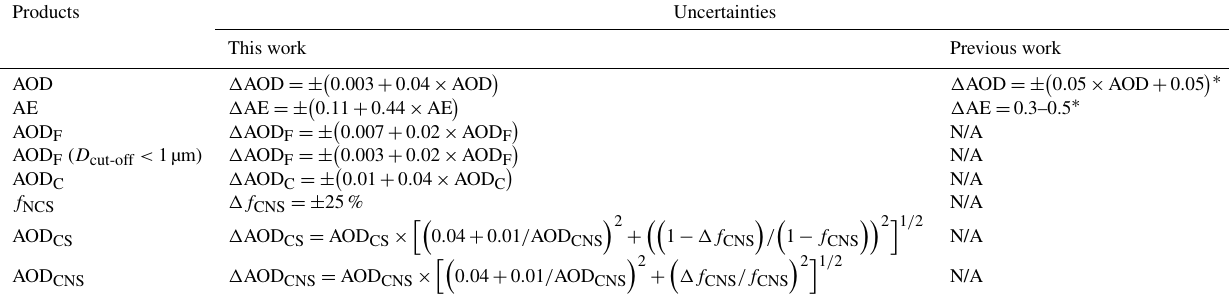
Table 4. Summary of evaluated uncertainties on POLDER-3 advanced products AOD, AE, AOD F , AOD C , and f CNS , and comparison to previous evaluations. N/A stands for not